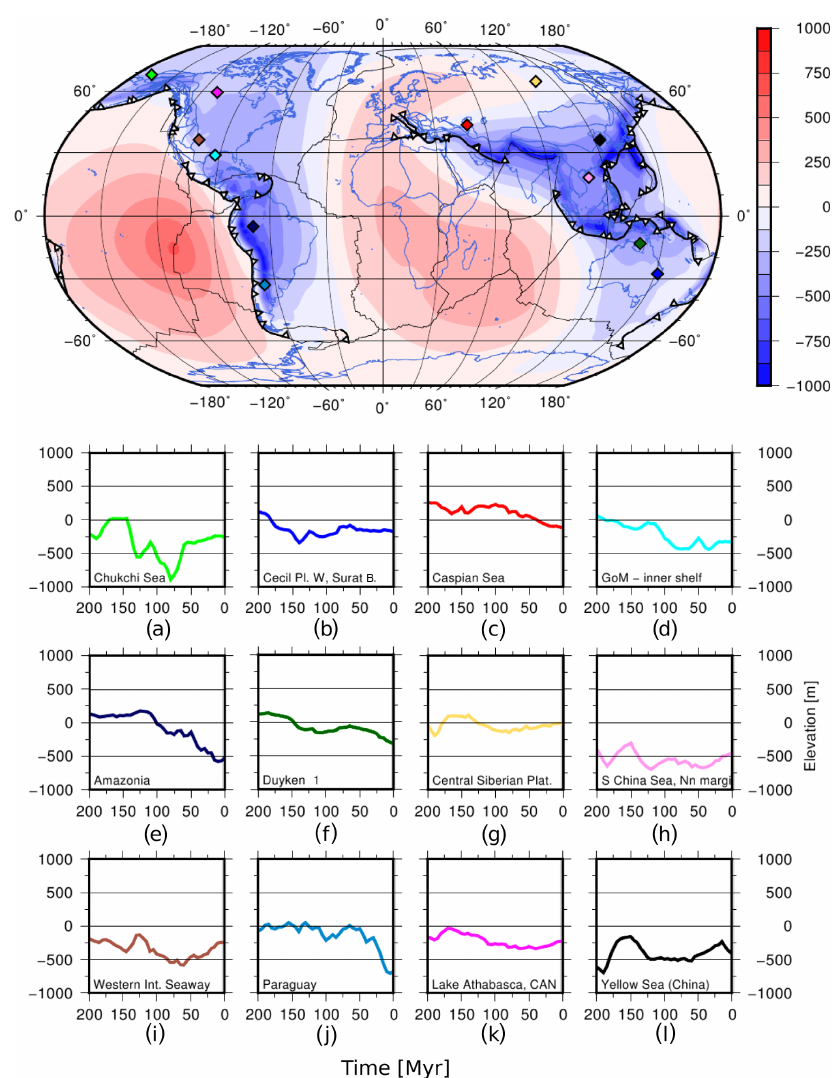
Figure 12. Overview (top) and time series (bottom) plot of dynamic topography for Category III, “fluctuating areas”.